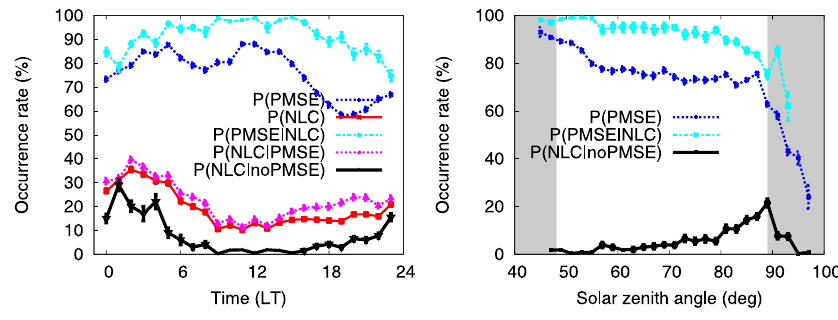
Fig. 7. Occurrence rates as function of local time and solar zenith angle.